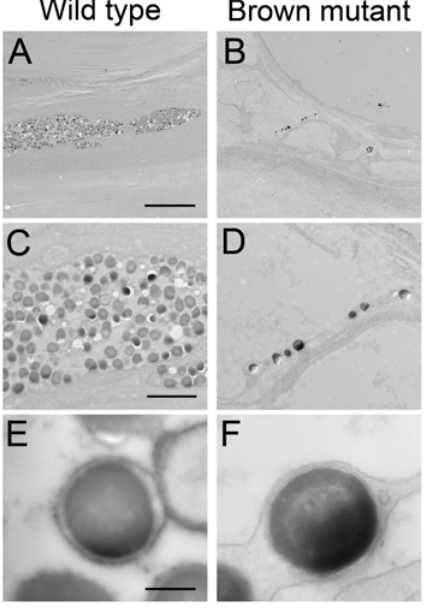
Figure 8. Brown mutant melanophores contain a lower number of melanin granules compared to wild type. Corresponding ultra- thin (95 nm) sections through tail tissue of a representative (A,C,E) Surface and (B,D,F) brown mutant individual (carrying two copies of the Pacho´n D 23,24 allele) were processed and imaged using high- resolution electron microscopy. Wild type tissue sections routinely demonstrated densely packed granules of melanin, while sections through brown mutant tissue contained far fewer melanin granules. Overall, melanin granules identified in wild type and brown mutants were the same size and contain comparable amounts of melanin. Scale bars: A,B=10 m m; C,D=2.5 m m; E,F=250 nm.